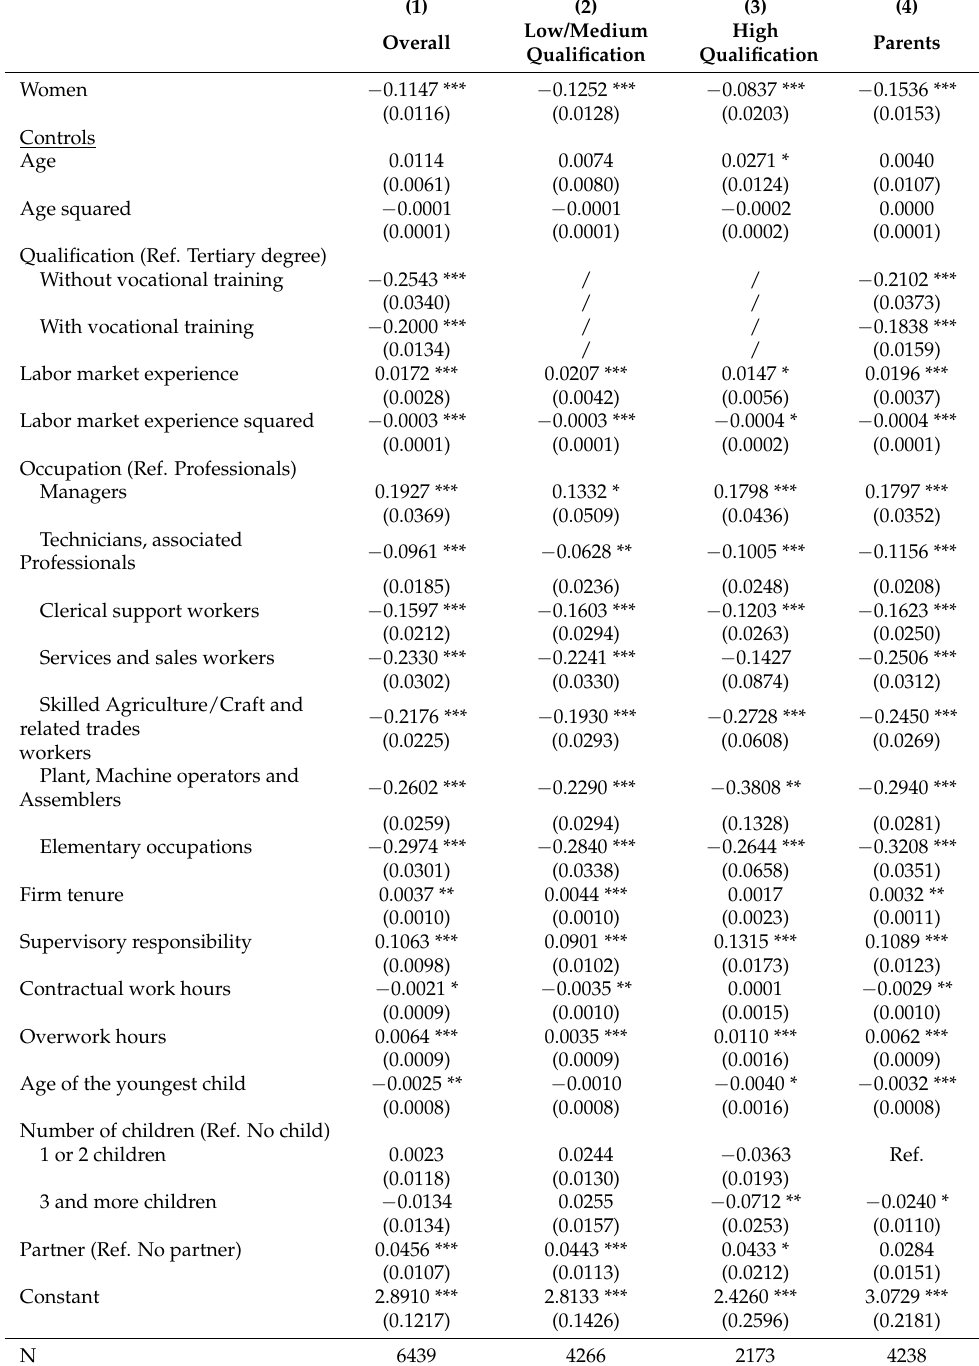
Table A3. Association of gender with log hourly wages including controls (extended version of Table 3, step